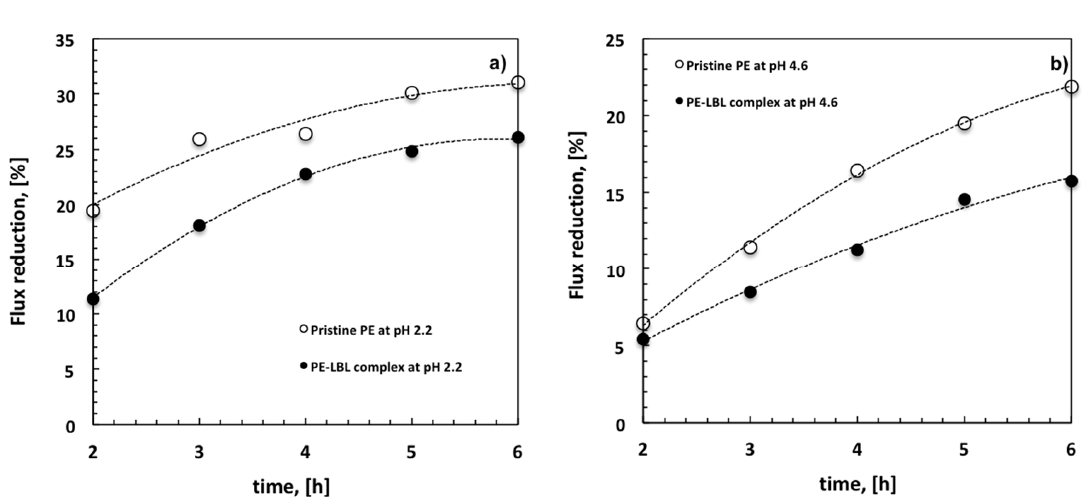
Figure 8. Comparative flux reduction for pristine PE and PE-LBL membranes at pH 2.2 ( a ) and 4.6 ( b ) under irradiation.